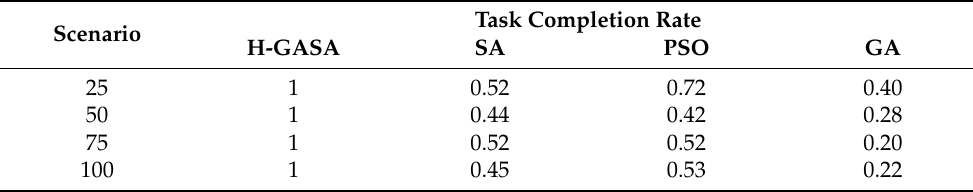
Table 7. Results of task completion rate of comparison algorithms with different target